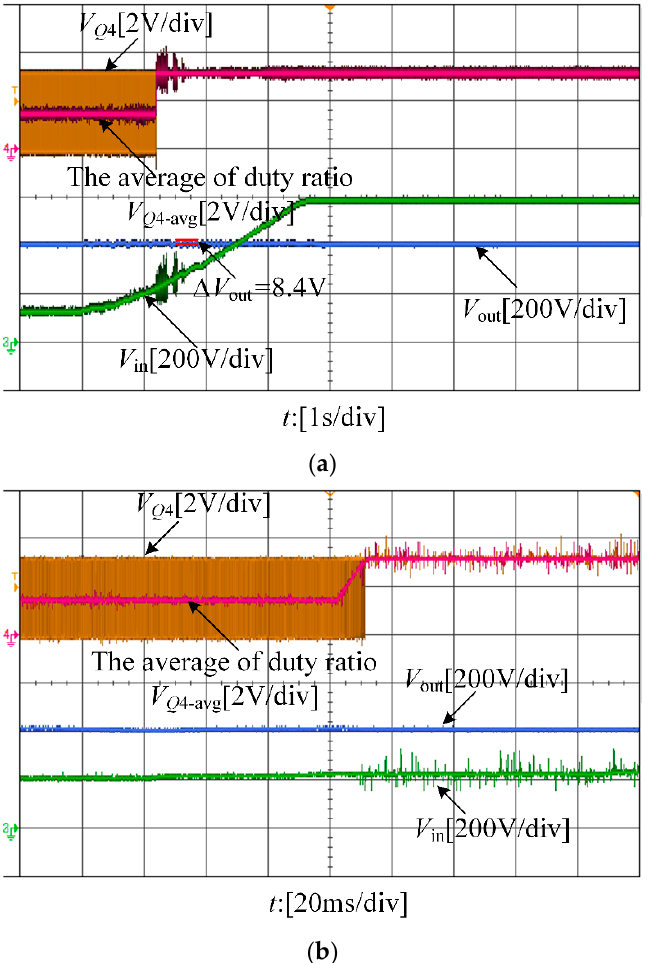
Figure 18. Experimental waveforms of transient switching process b with gradual adjustment control method. ( a ) Overall switching waveforms; ( b ) Enlarge detailed waveforms.